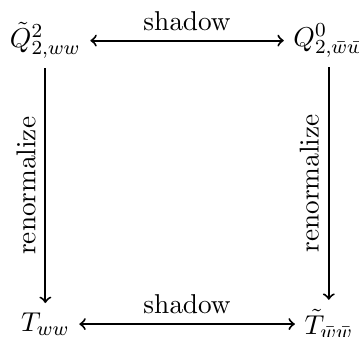
Figure 3. The shadow [59] and renormalization [29] procedures commute. The renormalized quantities f T ww ; e T (cid:22) w (cid:22) w g correspond to soft charges appearing in [8] and [32],